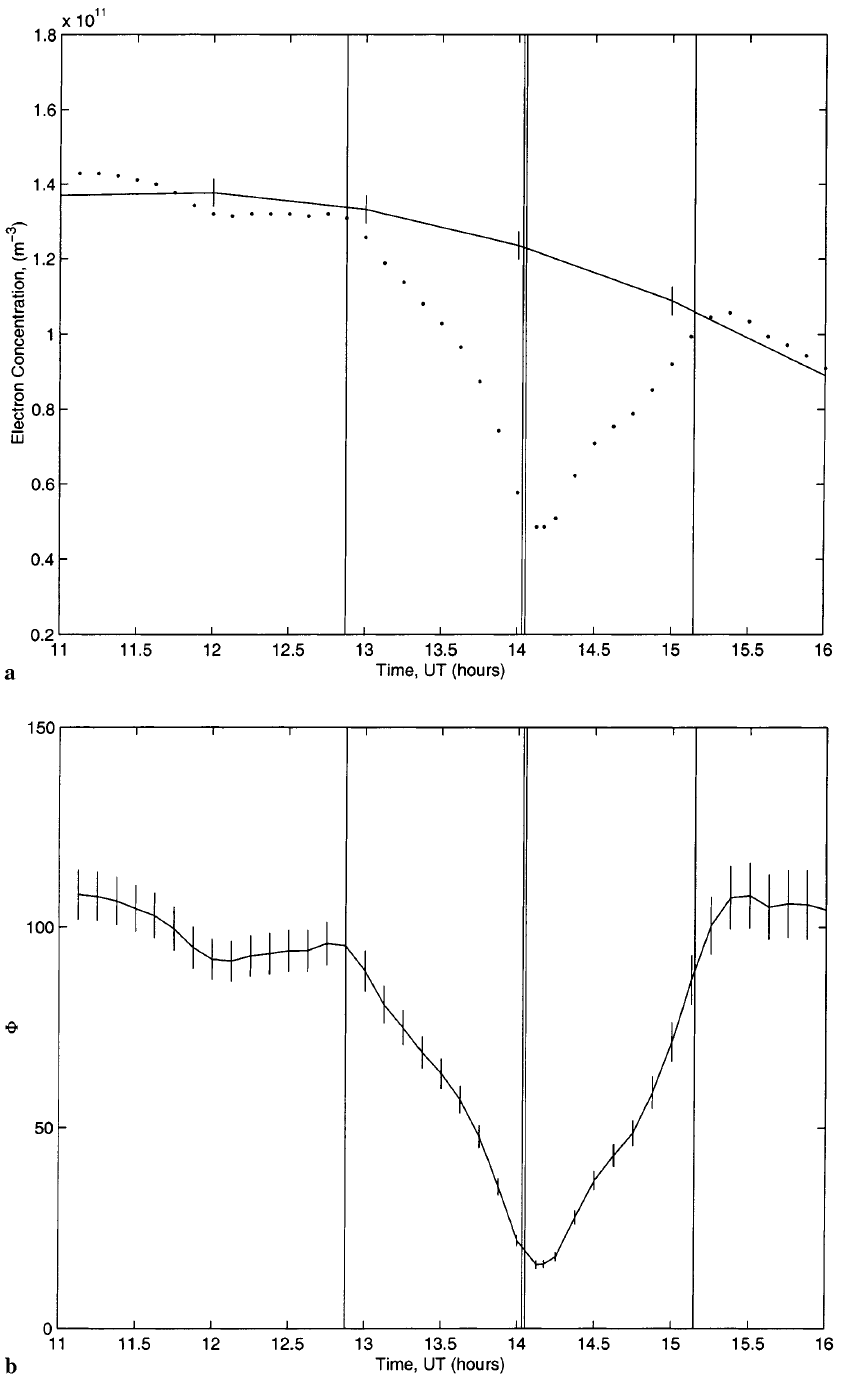
Fig. 5. a Electron concentration measure- ments along with the ‘‘control day’’ curve for the duration of the 1945 eclipse. The four vertical lines represent first, second, third and fourth contact at 100 km with respect to the photosphere. b The obscuration function, U (in %) for the duration of the 1945 eclipse. U reaches a minimum value of 16